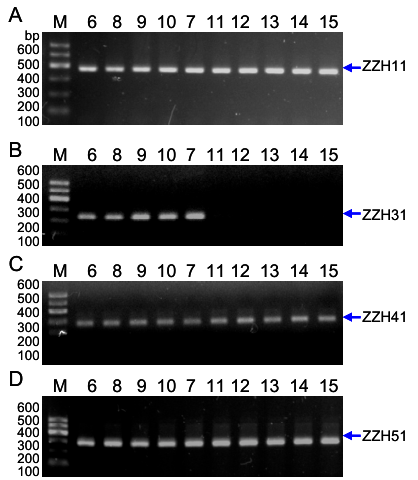
Figure 7. Genetic authentication of more Gardenia jasminoides sample based on ZZH11 ( A ); ZZH31 ( B ); ZZH41 ( C ) and ZZH51 ( D ) SCAR markers. Lanes 6, 8, 9, 10 and 11 are the DNA samples of G. jasminoides Ellis var. grandiflora Nakai from Zhejiang, Guangdong, Fujian, Hunan and Anhui respectively (Table 1, Nos. 6, 8, 9, 10 and 11). Lane 7, 12, 13, 14 and 15 are samples of G. jasminoides from Luzhou in Sichuan, Jiangsu, Jiangxi, Hunan and Shanxi respectively (Table 1, Nos., 7, 12, 13, 14 and 15). Lane M indicates the DNA molecular weight marker DL600 with the fragment size (bp).